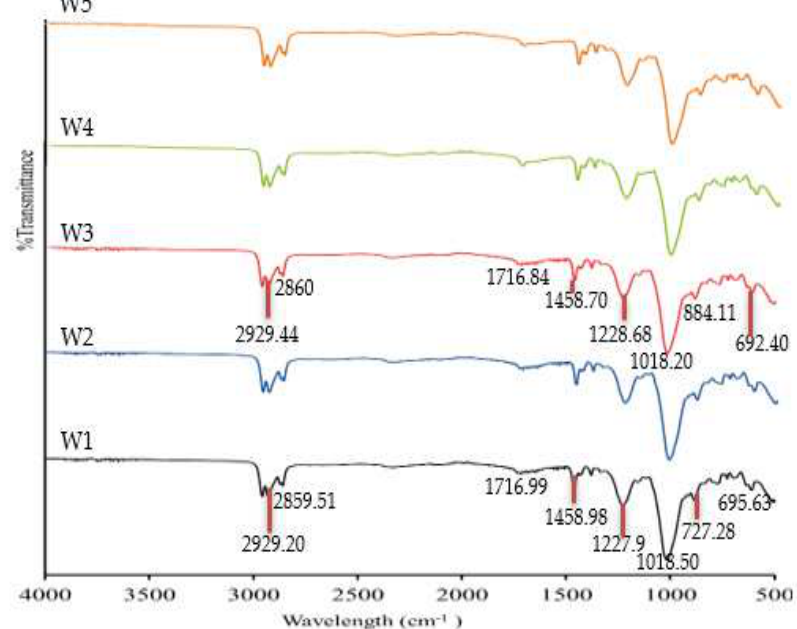
Figure 3. The FTIR spectra of the fabricated membranes prior to Zn 2+ removal.